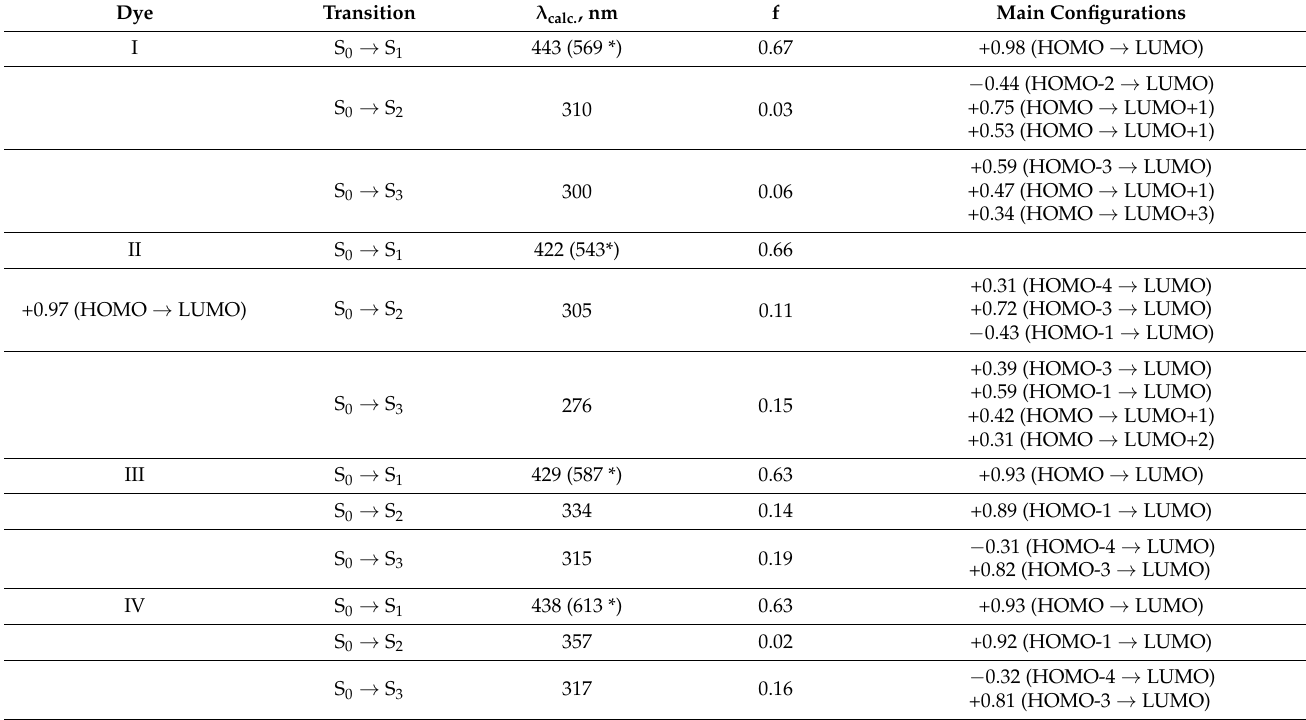
* λ exp. is the wavelength of the electronic transition, determined from fluorescence and absorption spectra.